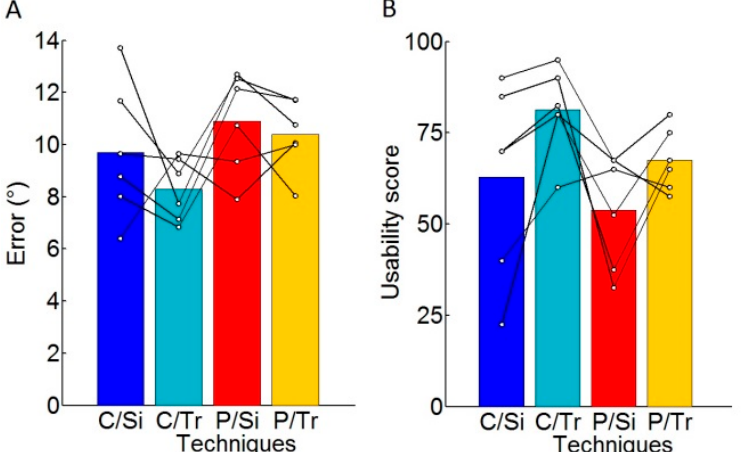
Figure 3. Techniques efficiency and usability. ( A ) The average pointing error for each technique is represented with color bars. The mean errors per subject and per technique are represented with white dots. The C/Tr technique shows the lowest average error (mean=8.2°) with the smallest inter subject variability (standard deviation=1.2°). ( B ) The average usability (SUS) for each technique is represented with color bars. The usability score per subject and per technique is represented with white dots. The C/Tr technique received the highest usability score with 81.3 ± 12.0. (C: Cartesian; P: Polar; Si: Single stimuli; Tr: Train of pulses).